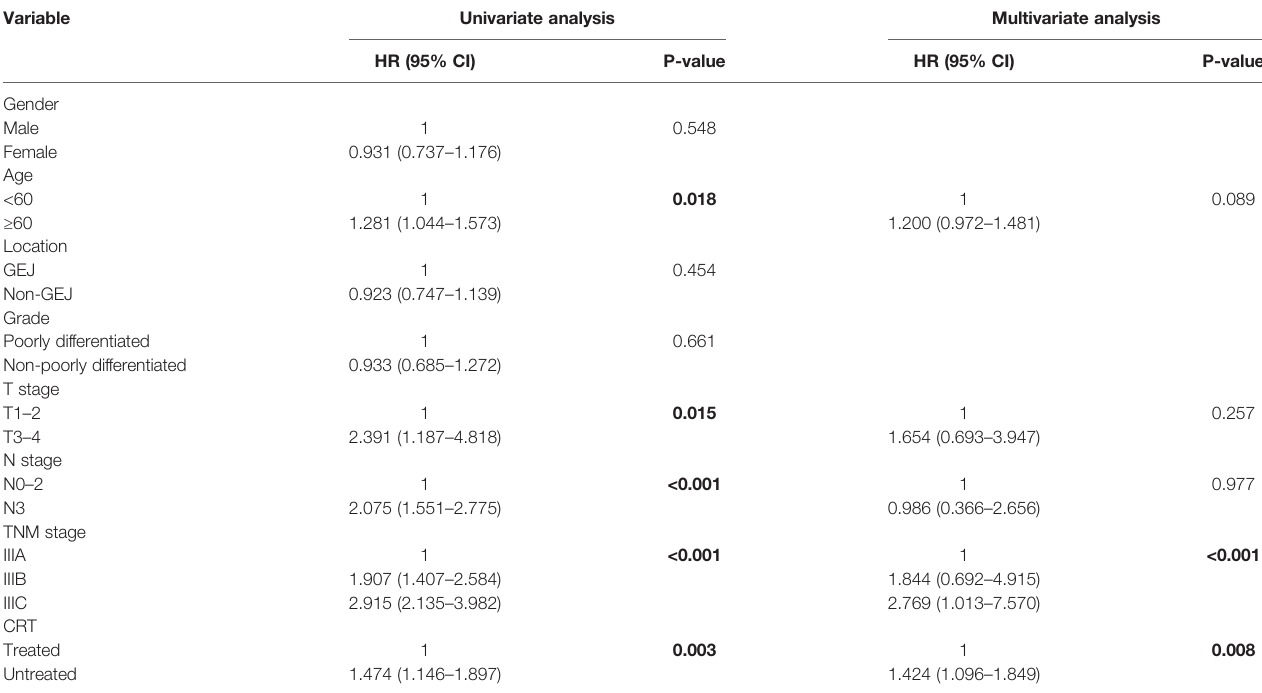
TABLE 3 | Univariate and multivariate Cox regression analyses for overall survival.